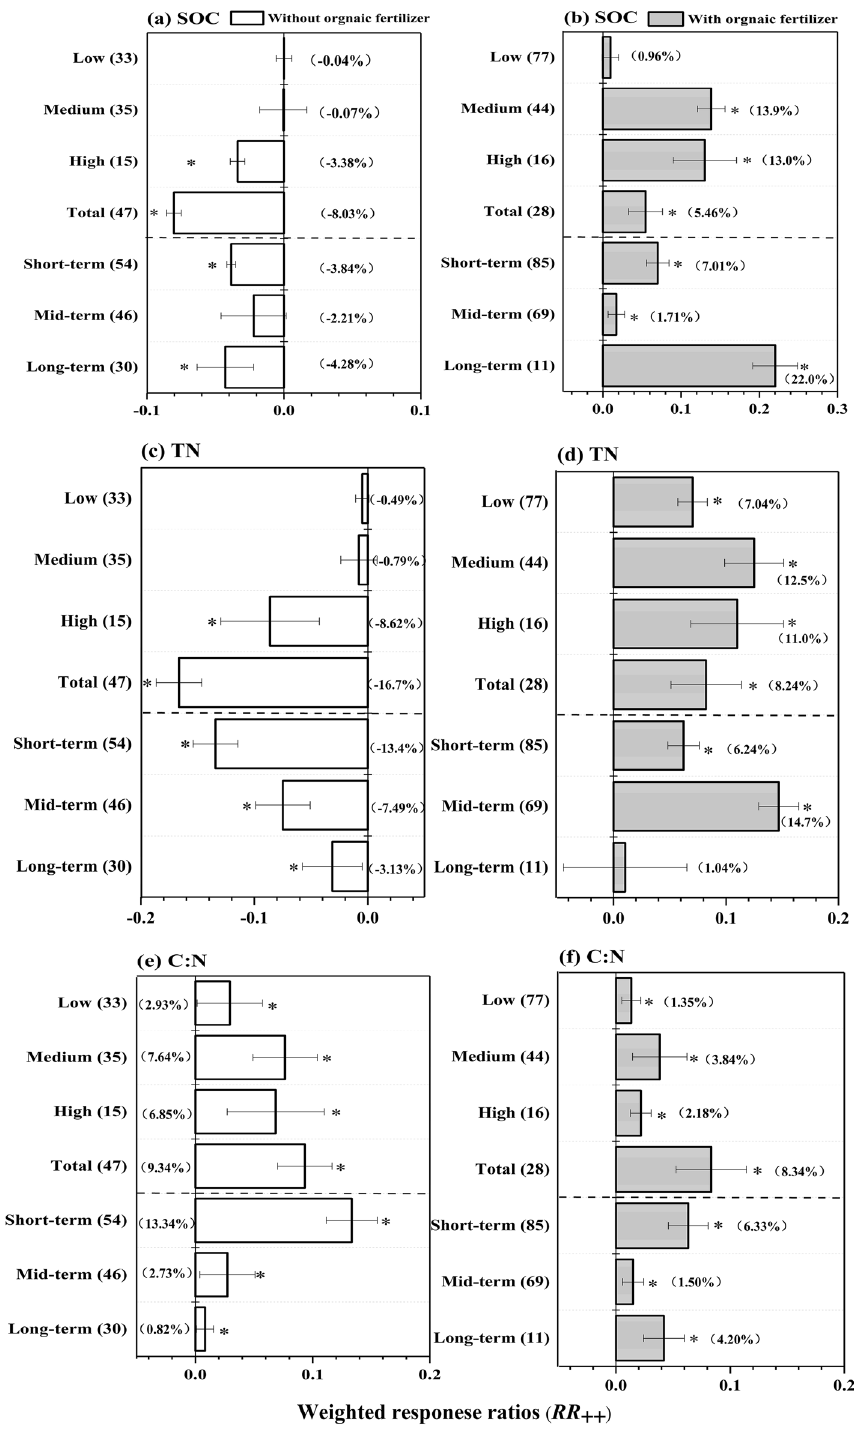
Figure 2. The weighted response ratio ( RR ++ ) for the responses to chemical nitrogen fertilizers of soil organic carbon (SOC, a ), total nitrogen (TN, b ), and their ratios (C:N, c ) under the two patterns (with organic fertilizers ; without organic fertilizers). Bars denote the overall mean response ratio RR ++ and 95% confidence intervals (CI). The star (*) indicates significance when the 95% CI that do not go across the zero line. The vertical lines are drawn at ln RR = 0. The values represent independent sample